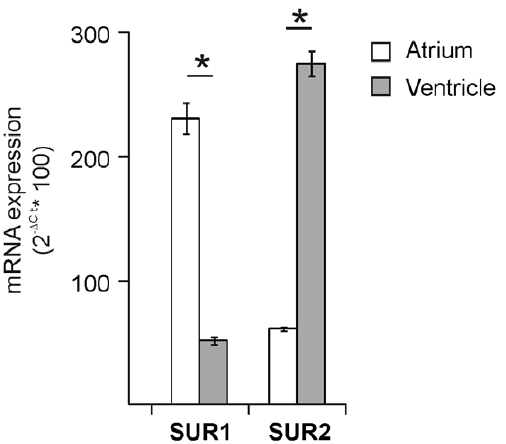
Figure 1. Regional SURx subunit transcription in the mouse heart. Relative mRNA expression of SUR1 and SUR2 obtained in atrial and ventricular tissue (n=3 hearts each). Expression (normalized to Hprt ) was assessed by quantitative RT-PCR. Gene-specific Taqman primer and probes were obtained from Applied Biosystems. SUR1 expression was significantly elevated in atrial tissue compared with ventricle, while the opposite distribution was observed for SUR2 (*P , 0.001,